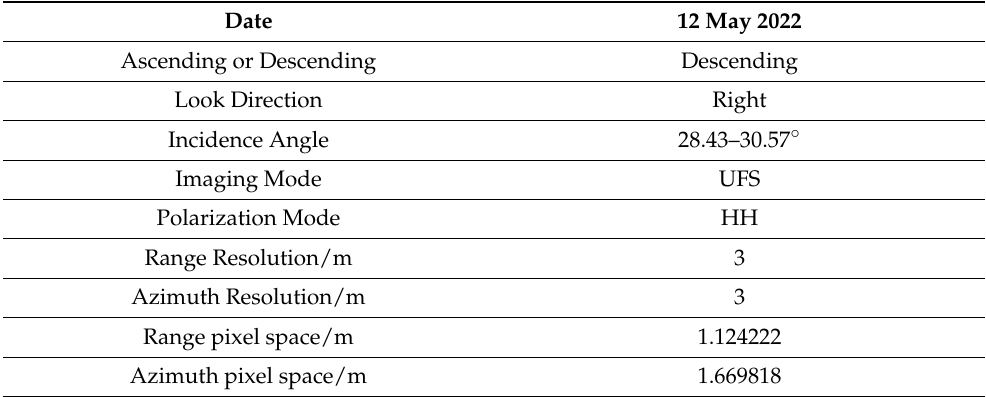
Table 2. Imaging parameters of C-SAR/01